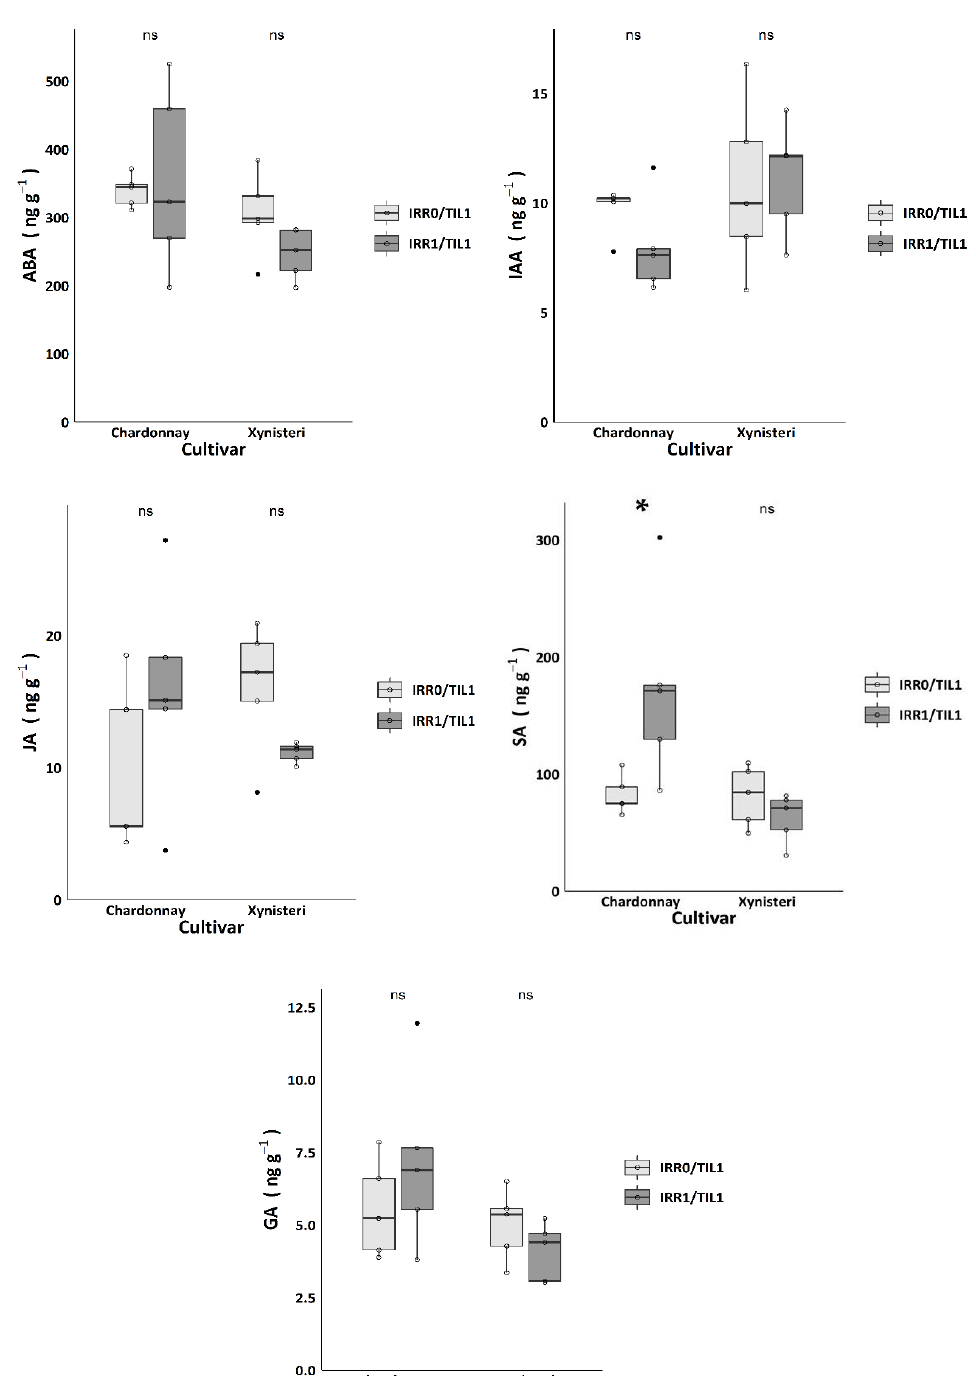
Figure 5. E ff ects of irrigation on Chardonnay and Xynisteri cultivars under tillage on plant hormones. Leaf hormones were abscisic acid (ABA; ng g − 1 Fw), indole-3-acetic acid (IAA; ng g − 1 Fw), jasmonic acid (JA; ng g − 1 Fw), salicylic acid (SA; ng g − 1 Fw) and gibberellic acid (GA; ng g − 1 Fw). Values are means of five ( n = 5) replicates. Star symbol shows significant di ff erences at p < 0.05; ns: not significant. All observations are shown as dots. The line inside the box and the lower and upper boundary of the box represent the median, first and third quartile, respectively. The whiskers indicate the minimum and maximum, excluding outliers (full dots), which are observations outside the 1.5 times interquartile range of the first or third